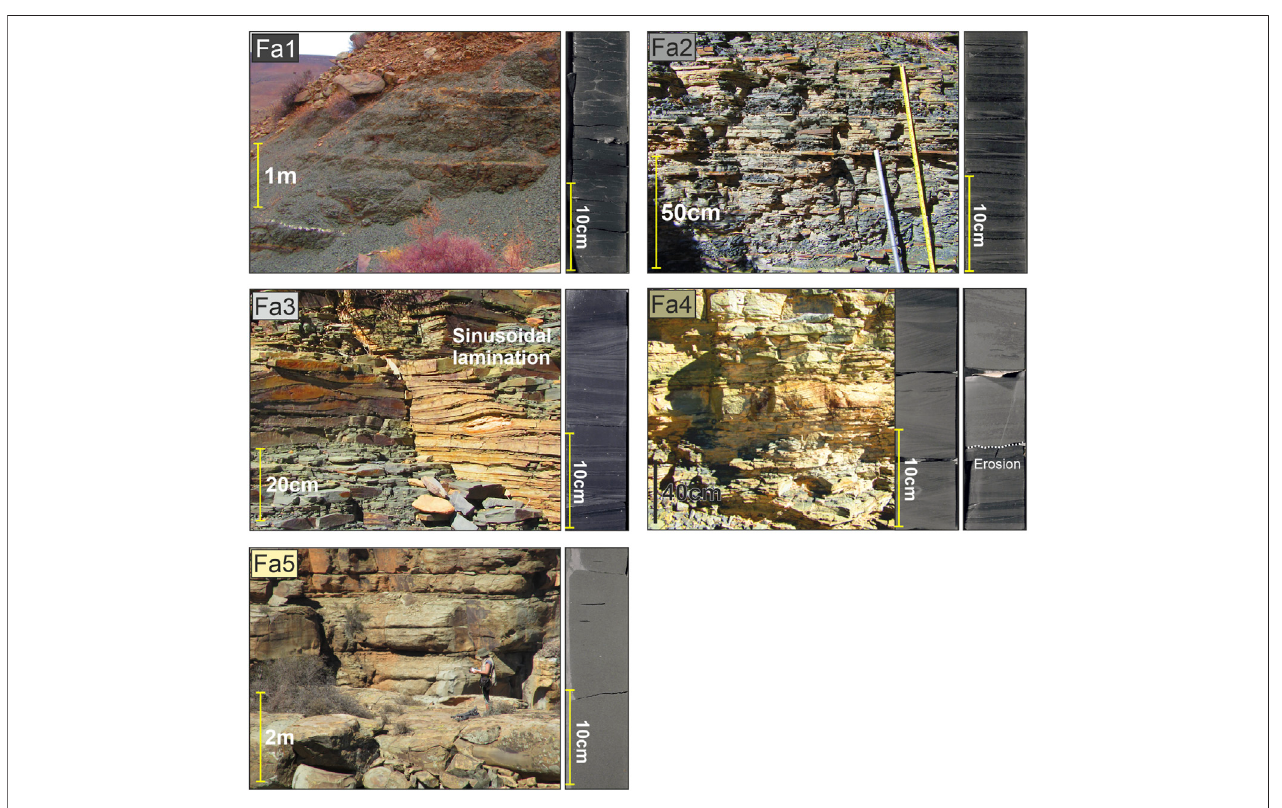
FIGURE 3 | Representative photographs of the fi ve sedimentary facies in outcrop and core: FA1- Mudstone, FA2 – Siltstone-prone heterolithics, FA3 – Sandstone- prone heterolithics, FA4 – Thin to medium-bedded sandstone, FA5 – Medium to thick-bedded sandstone.